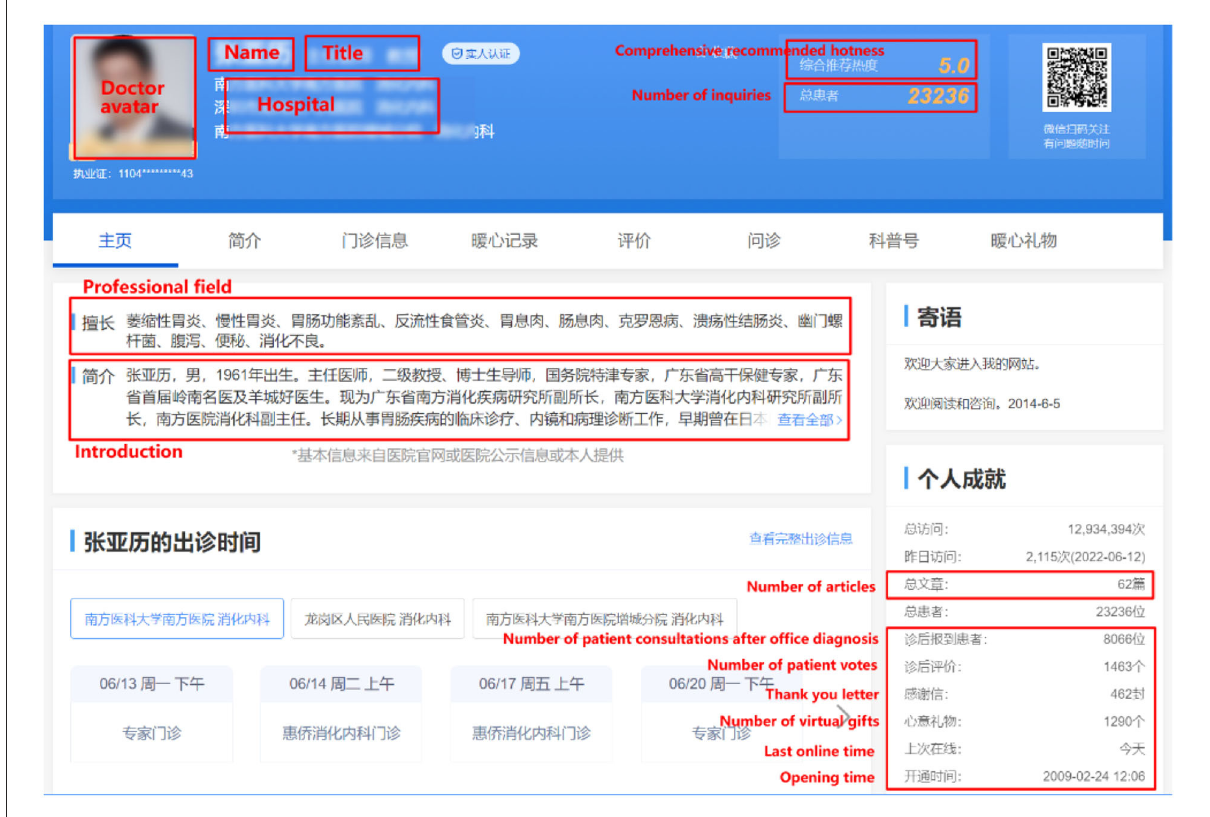
FIGURE2 Good Doctor website physician information